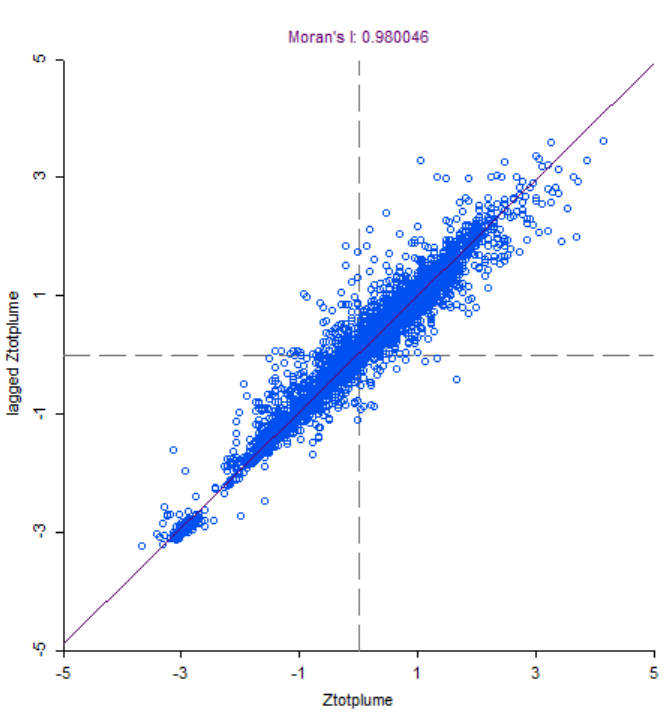
Figure 3. Global Moran’s I for